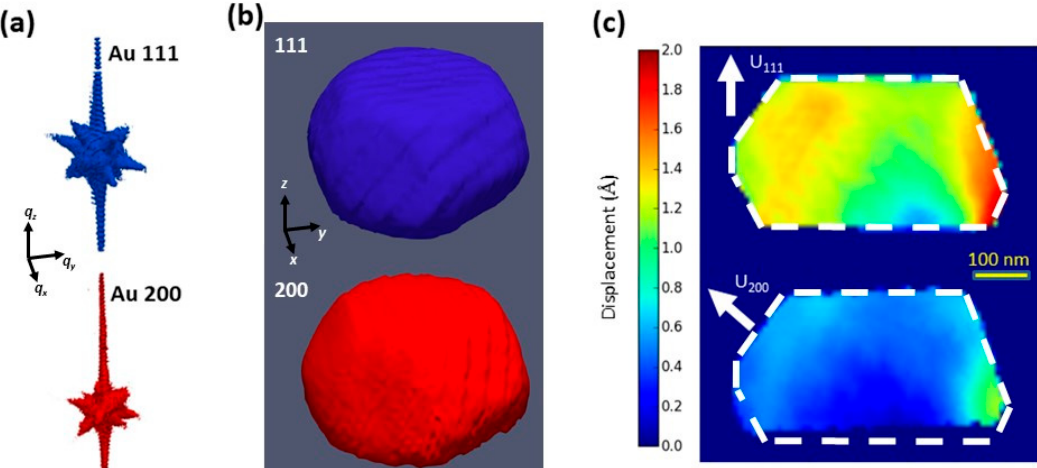
Figure 4. ( a ) 3D reciprocal space maps of the Au 111 and Au 200 Bragg peaks measured simultaneously using an Eiger 2 M and a MAXIPIX detector. ( b ) Isosurface of the Bragg electronic density reconstructed object from the Au 111 and 200 Bragg peaks. ( c ) Vertical cuts of the 3D displacement field component. The dotted white contours are guides for the eyes and delimit the shape of the crystal measured at the Au 111 Bragg reflection. Crystals 2021 , 11 , x FOR PEER REVIEW